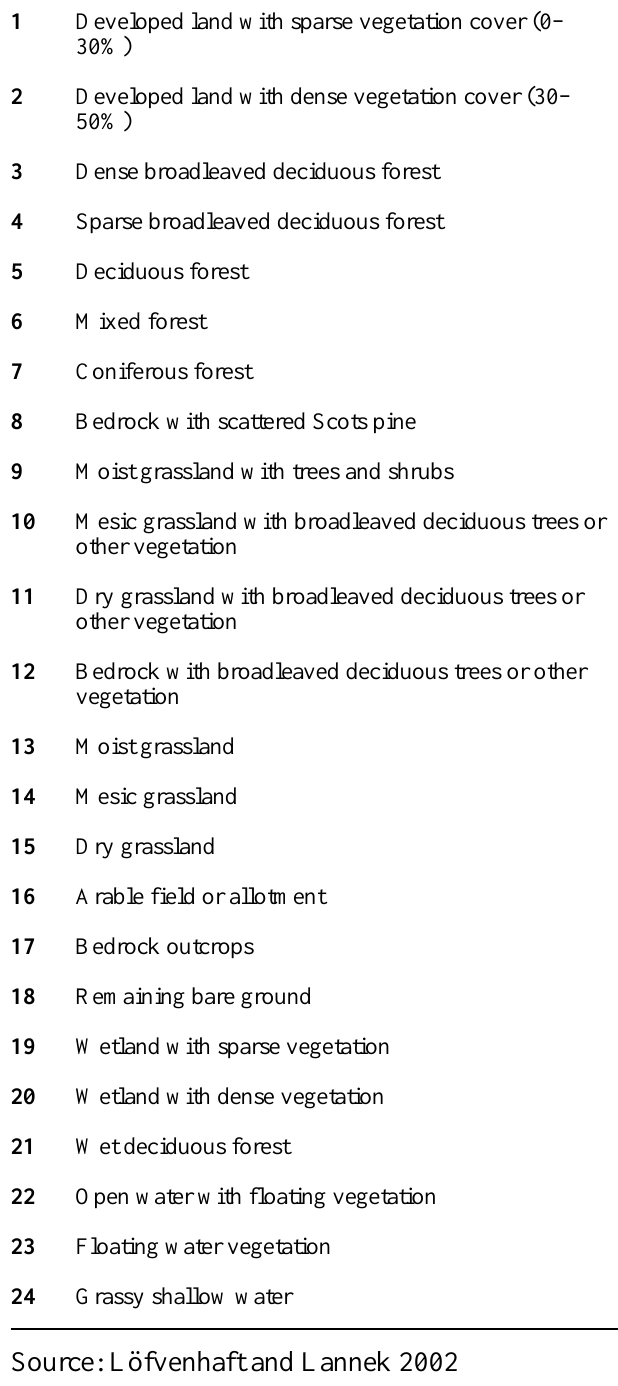
Table 1 . Number of different types of biotopes found within the National Urban